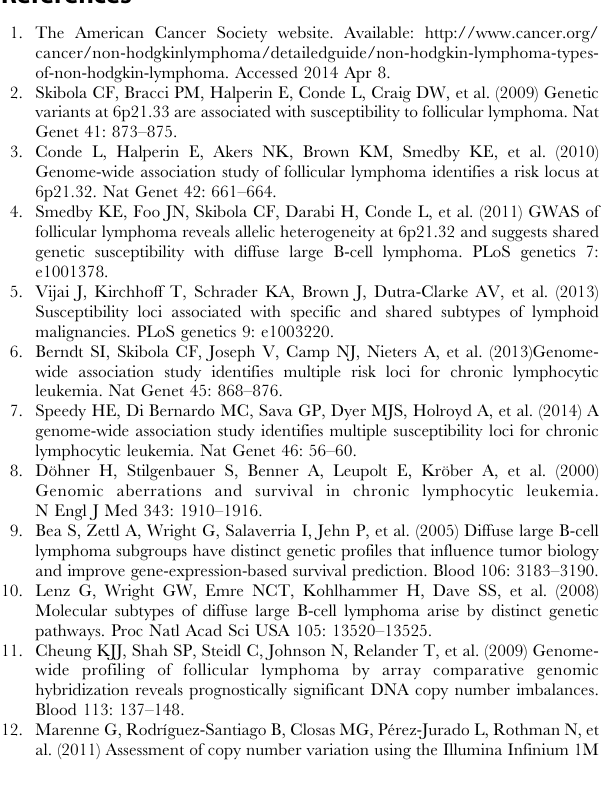
Table S4 Aberrations found in the CLL/SLL cases at nominal P , 0.05. Aberrations that remained significant after correction (P_FDR , 0.05) are shown in bold. Table S5 Genes significantly deleted in the CLL/SLL cases (FDR p-value ,